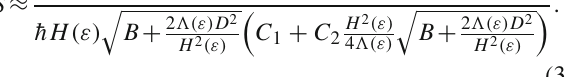
= 10, C = 1, p = 1, and B = 1 1 2 0